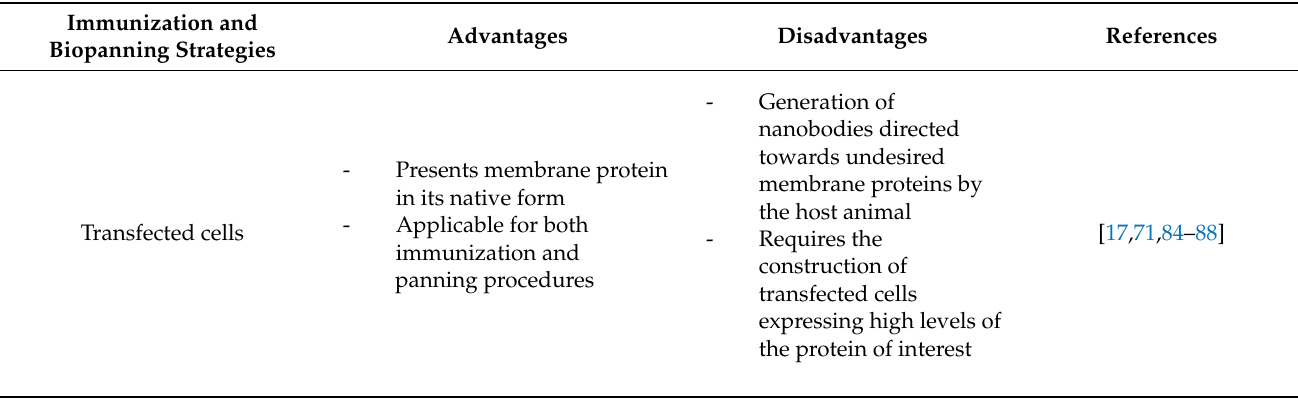
Table 1. Overview of immunization and biopanning strategies for the identification of cell plasma membrane-protein targeting